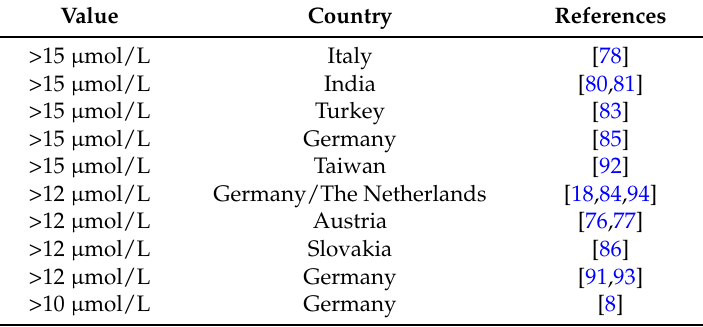
Table 2. Hyperhomocysteinemia criteria.